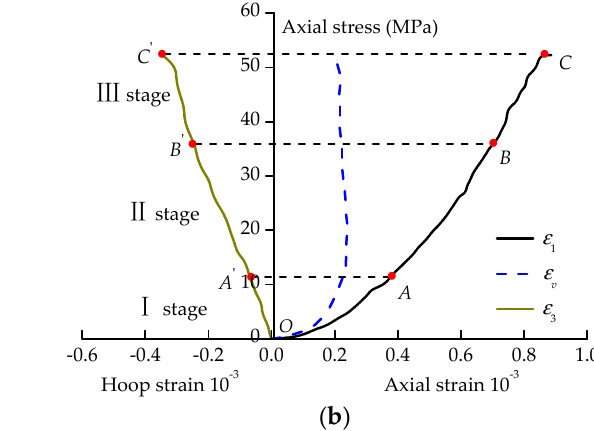
( b ) Figure 5. Stress − strain curves under parallel loading: ( a ) Gray samples; ( b ) Cinerous samples. The slate samples enter the elastic deformation stage (stage Ⅱ ) after the completion of existing micro-fractures and cementation compaction with further loading of axial stress. Thereafter, the integral rigidity increases and the stress-strain curve increases approximately linearly. The gray and cinerous samples show linear deformation when the load is perpendicular to the weak surface structures; axial compression controls the overall deformation, and the axial deformation is about 1.50 to 2.50 times that of hoop deformation, as shown in Figure 4. The rock pillar formed by superimposition is sufficient to support the axial load when the load is parallel to weak surface structures; the relative axial strain of gray slate and cinerous slate is smaller than the vertical loading condition, as shown in Figure 5. Tables 1 and 2 show that the average elastic modulus of the cinerous samples is significantly greater than that of the gray samples for both vertical and parallel loading. This is because the weak surfaces of the slate rock layers and main stresses are related in series during vertical loading, and slate rock is dominated by compression deformation while hoop deformation is constrained.